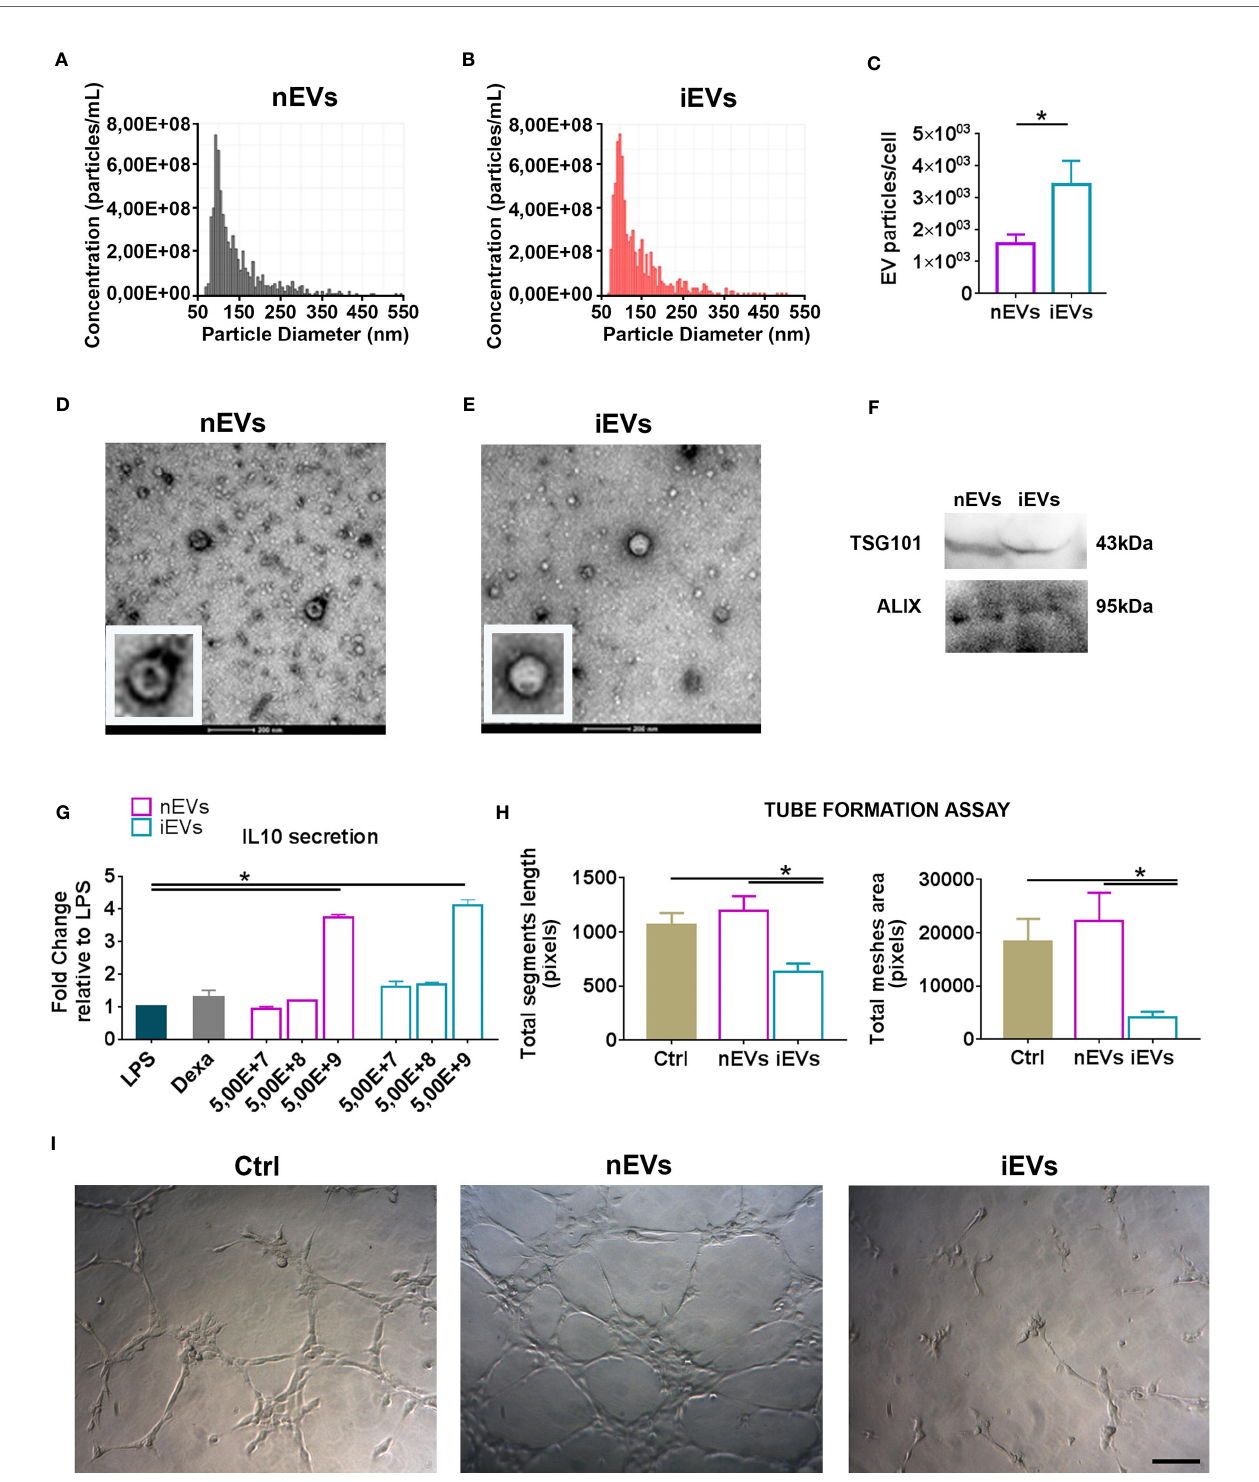
FIGURE 1 | Characterization of extracellular vesicles derived from mesenchymal stromal cells. (A) Representative size distribution of nEV and of (B) iEV analyzed by Resistive Pulse Sensing. (C) Number of nEVs and of iEVs secreted per cell. Result are mean ± standard error (n = 5 independent experiments, *P < 0.05). (D) Transmission electron microscopy analysis of freshly nEVs (E) and of freshly iEVs; scale bar refers to 200 nm. (F) Western Blot of nEVs and iEVs for TSG101 and Alix. (G) Macrophage functional assay. IL-10 quanti fi cation after LPS cell treatment. (n = 3 independent experiments, *P < 0.05). (H, I) Endothelial functional assay. Segment length and meshes area were measured after nEVs and iEVs treatment. (I) Representative phase contrast images. Scale bar: 100 m